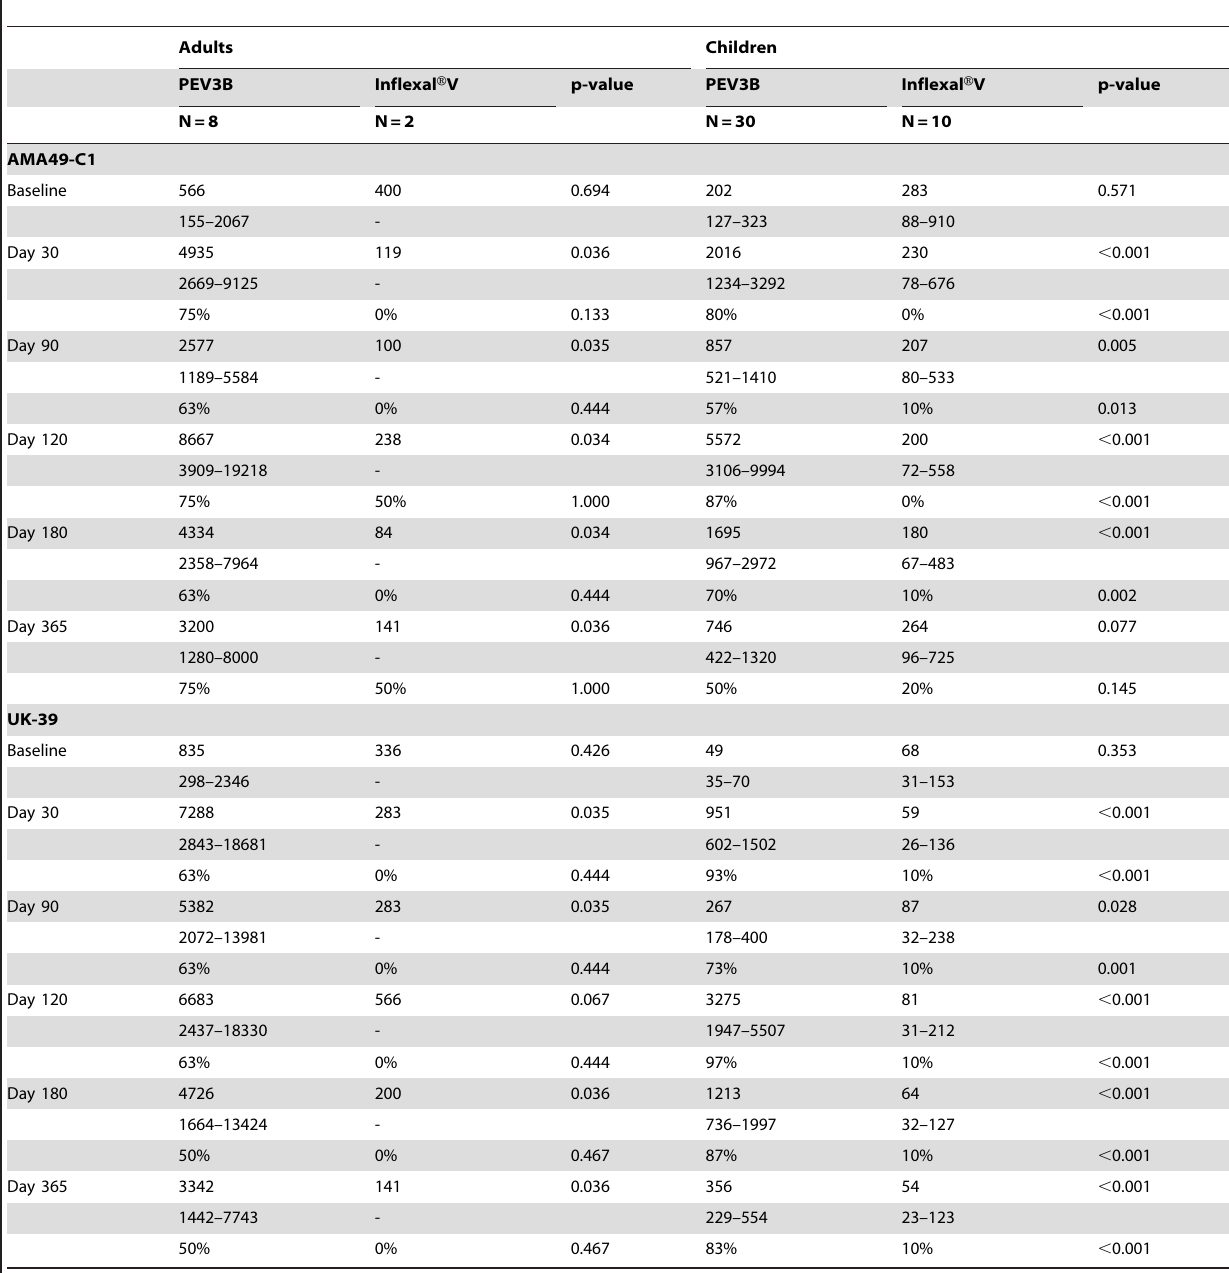
Table 2. Geometric means and corresponding 95% confidence intervals of anti-AMA-49-C1 and anti-UK-39 IgG ELISA endpoint titres, and the rate of responders (in %) among